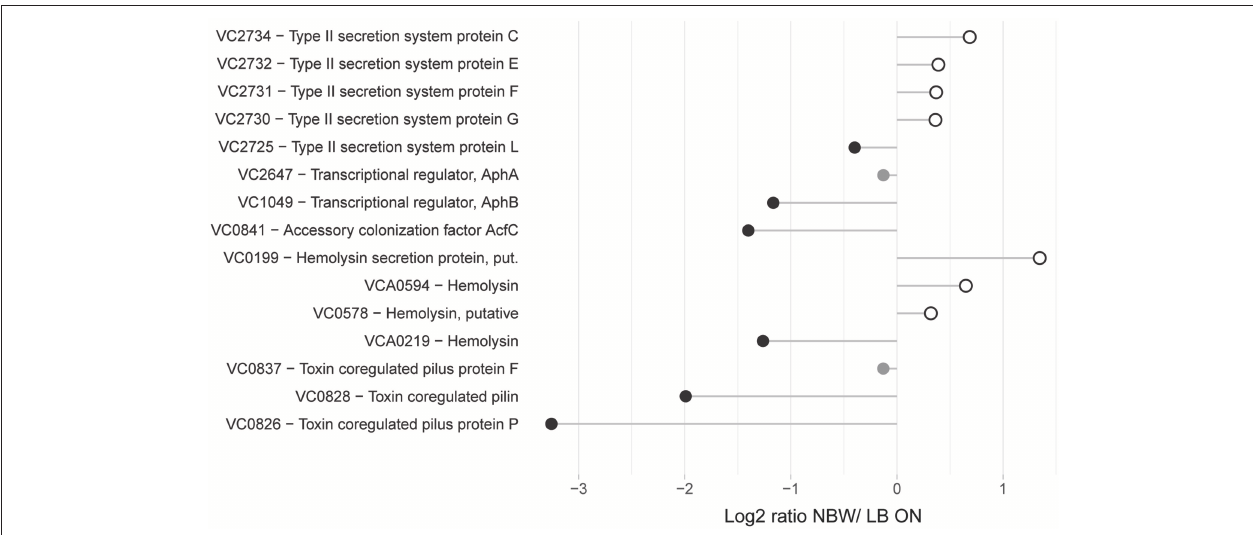
FIGURE 4 | Relative protein abundances of proteins associated with pathogenicity. Depicted is the log 2 -ratio of NBW VBNC cells and LB ON cells. Proteins found in significantly higher abundance in VBNC cells compared to LB ON are indicated by open white circles while significantly lower ratios are shown as black circles. Protein abundances that were not significantly different are colored gray (q <